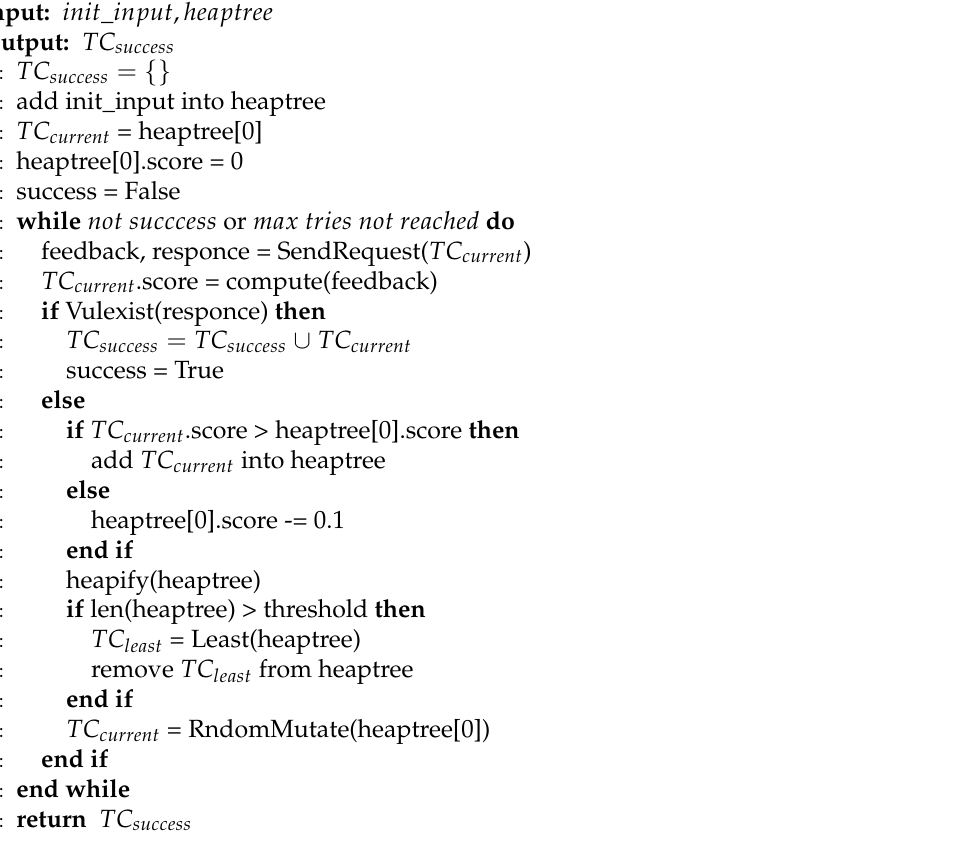
Algorithm 1 Dynamic Testing Algorithm Based on Feedback-Guided